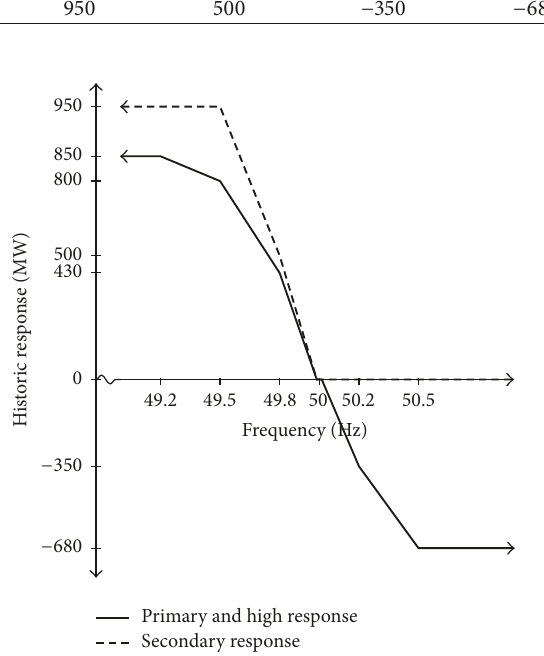
Figure 12: Representative historic response data with interpolation method for primary response (solid line below 50 Hz), secondary response (dashed line), and high response (solid line above 50 Hz). Zero response in the deadband ( 50 ± 0.015)